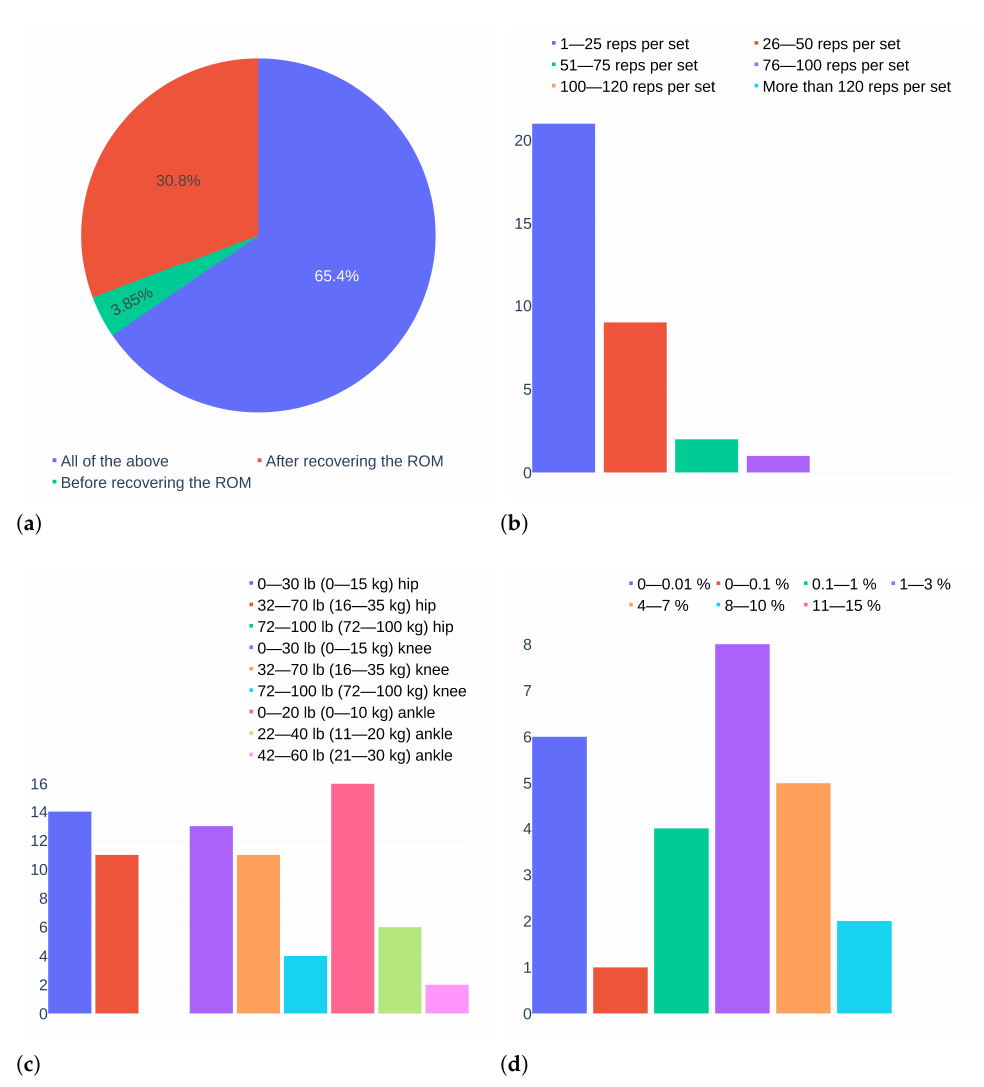
Figure A2. Results of the survey reporting that isotonic exercises should be ( a ) used in these rehabili- tation phases, ( b ) executed taking into account these speeds for the movements, ( c ) executed using these force ranges, and ( d ) executed with a human-robot interaction torque estimation with these maximum